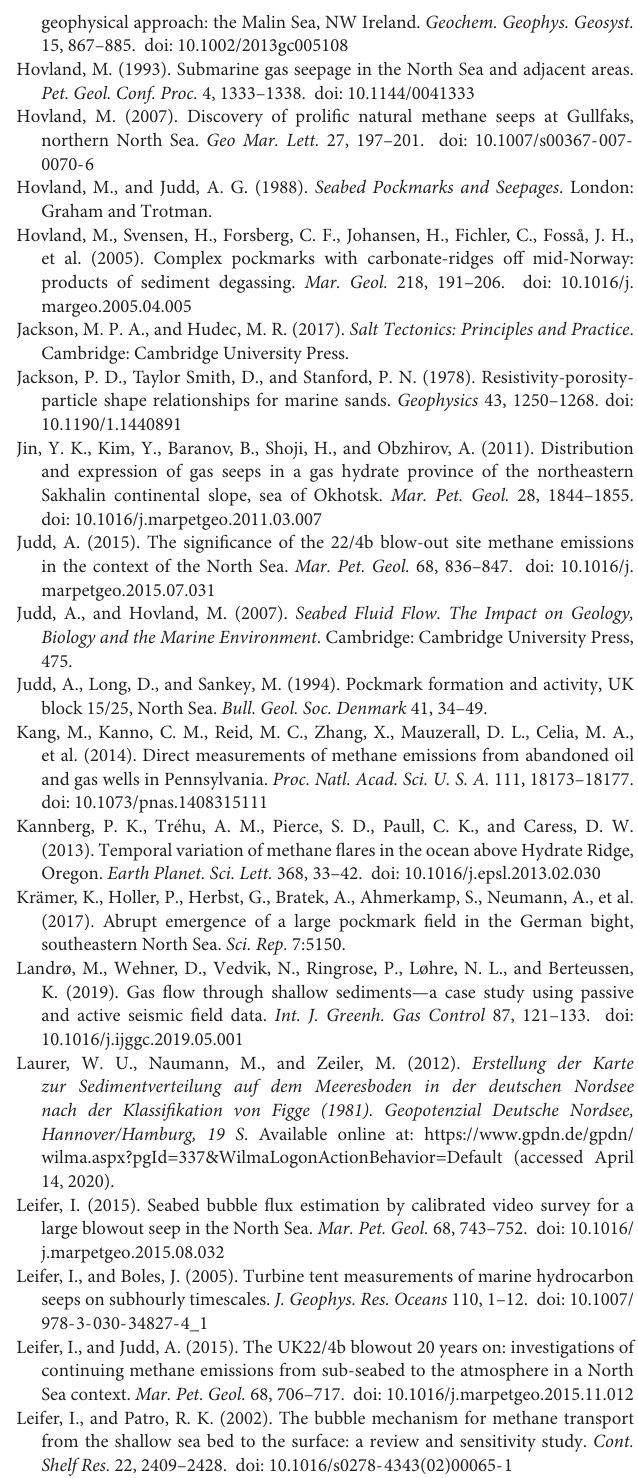
Supplementary Table 2 | List of CTD and MIC stations taken during R/V Heincke cruise HE537, including geographic position, area name and measured methane and ethane concentrations in the water samples taken. bdl: below detection